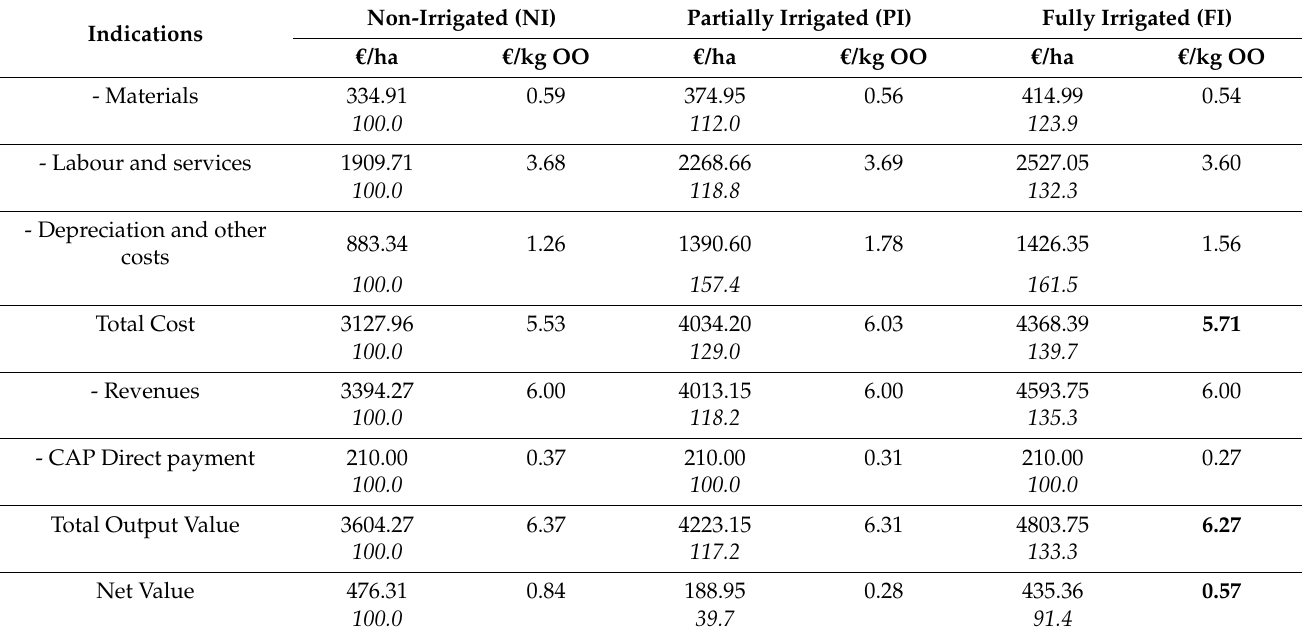
Table 5. Economic